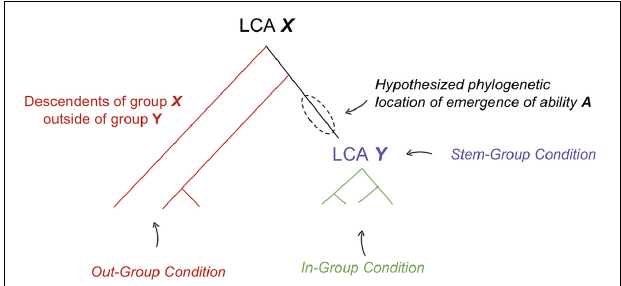
FIGURE 1 | Method for hypothesizing the phylogenetic location where a behavioral ability emerged. LCA, last common ancestor. See text for definitions of each